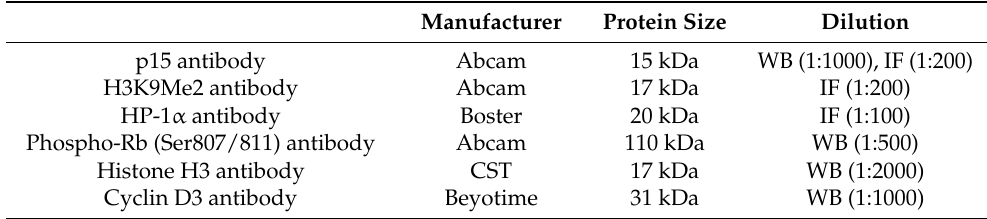
Table 2. Information and dilutions of primary